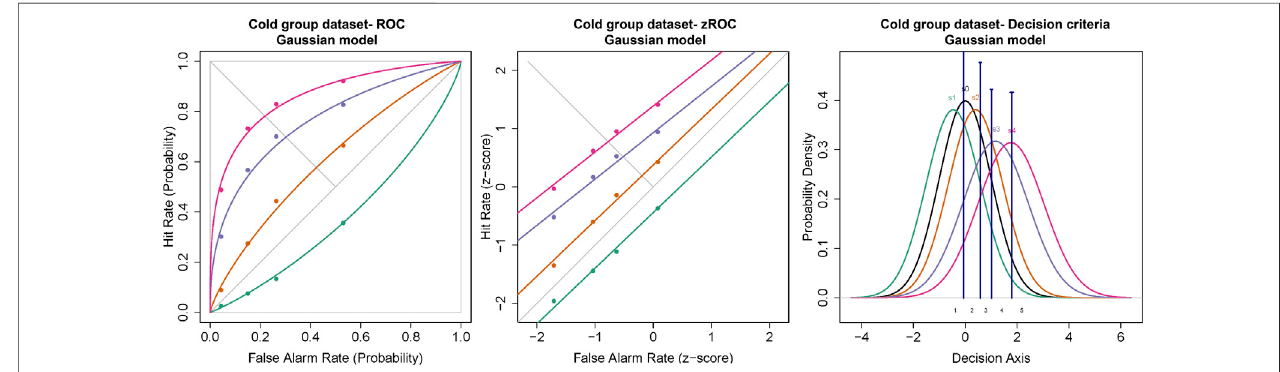
FIGURE 4 | ROC and Gaussian distribution for the cold stimuli. The green line represents the sub-threshold stimuli followed by orange (threshold), purple (1.5× threshold), and pink (2× threshold). The black line (S 0 ) in density functions represent the noise distribution.